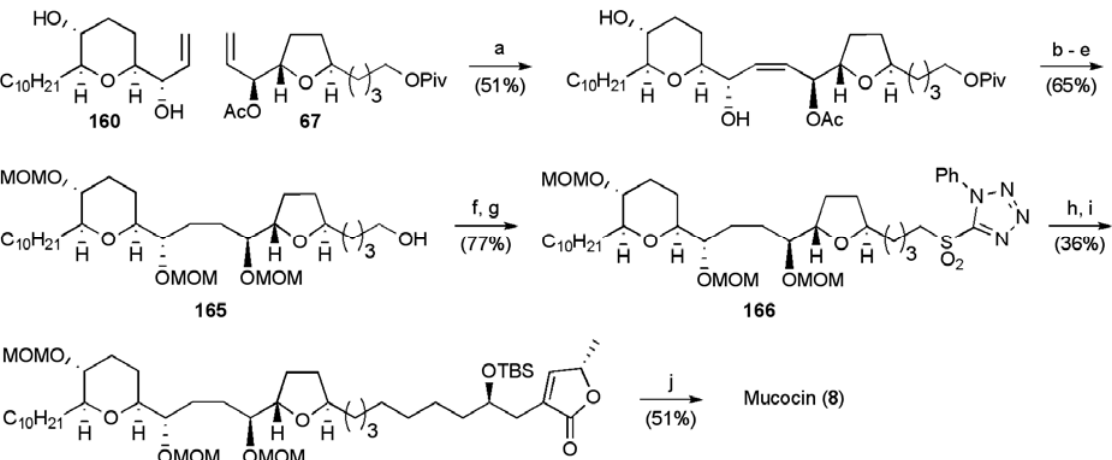
Scheme 39. Mootoo’s total synthesis of mucocin ( 8 ).